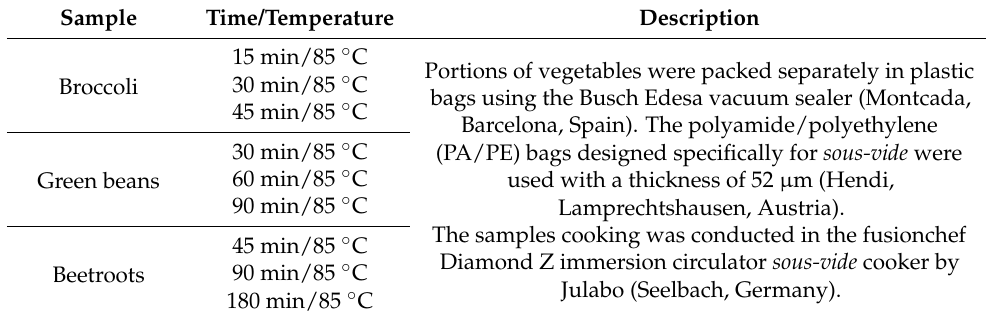
Table 1. Sous-vide parameters of vegetables samples